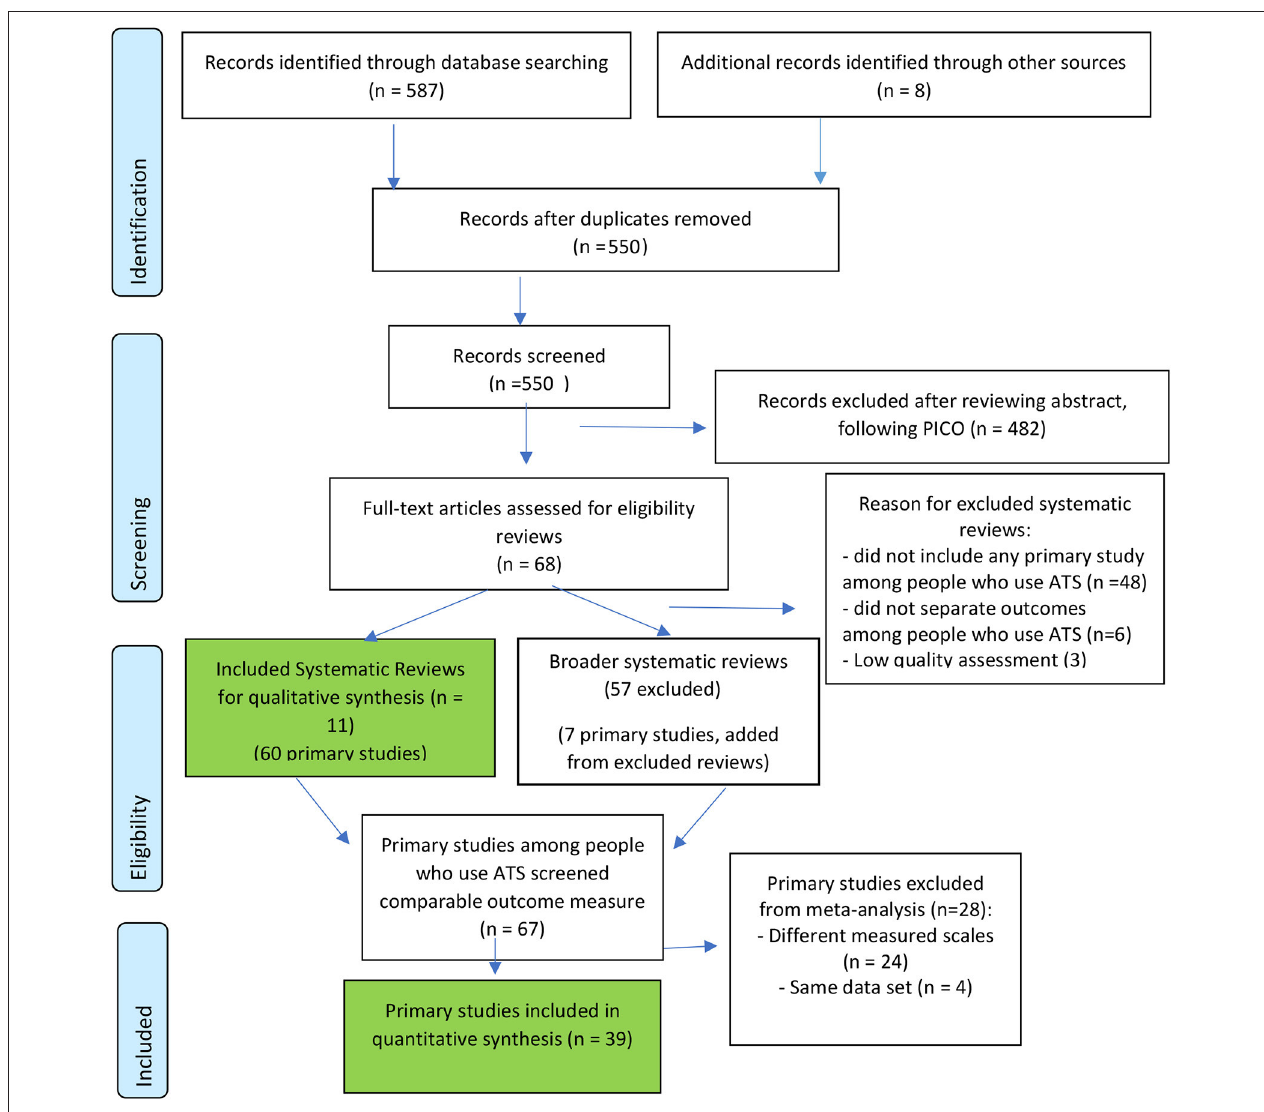
FIGURE 1 | Review and study flow